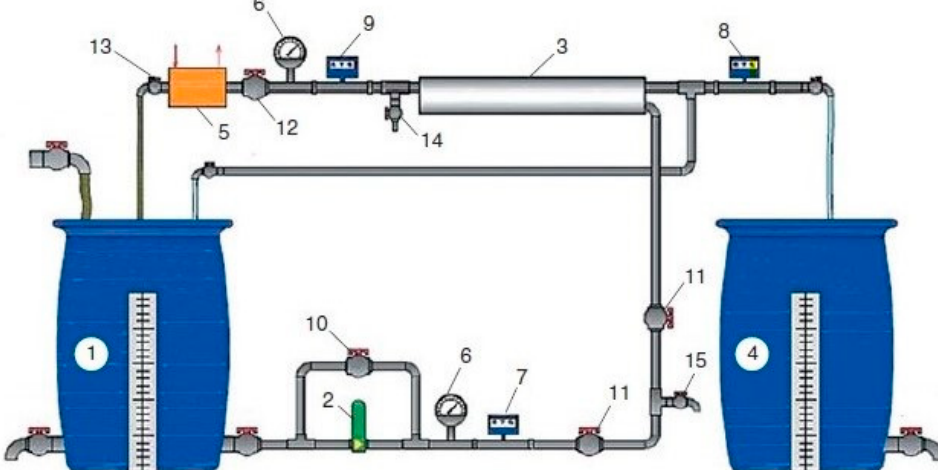
Figure 1. Laboratory test unit flow diagram: 1—source water tank; 2—pump; 3—membrane element in the pressure vessel; 4—filtrate tank; 5—heat exchanger; 6—manometer; 7–9—flow meters; 10—bypass valve; 11—valve for adjusting the flow of source water; 12—valve for adjusting the working pressure and concentrate flow; 13—valve for adjusting the flow of cooling water; 14, 15—samplers.